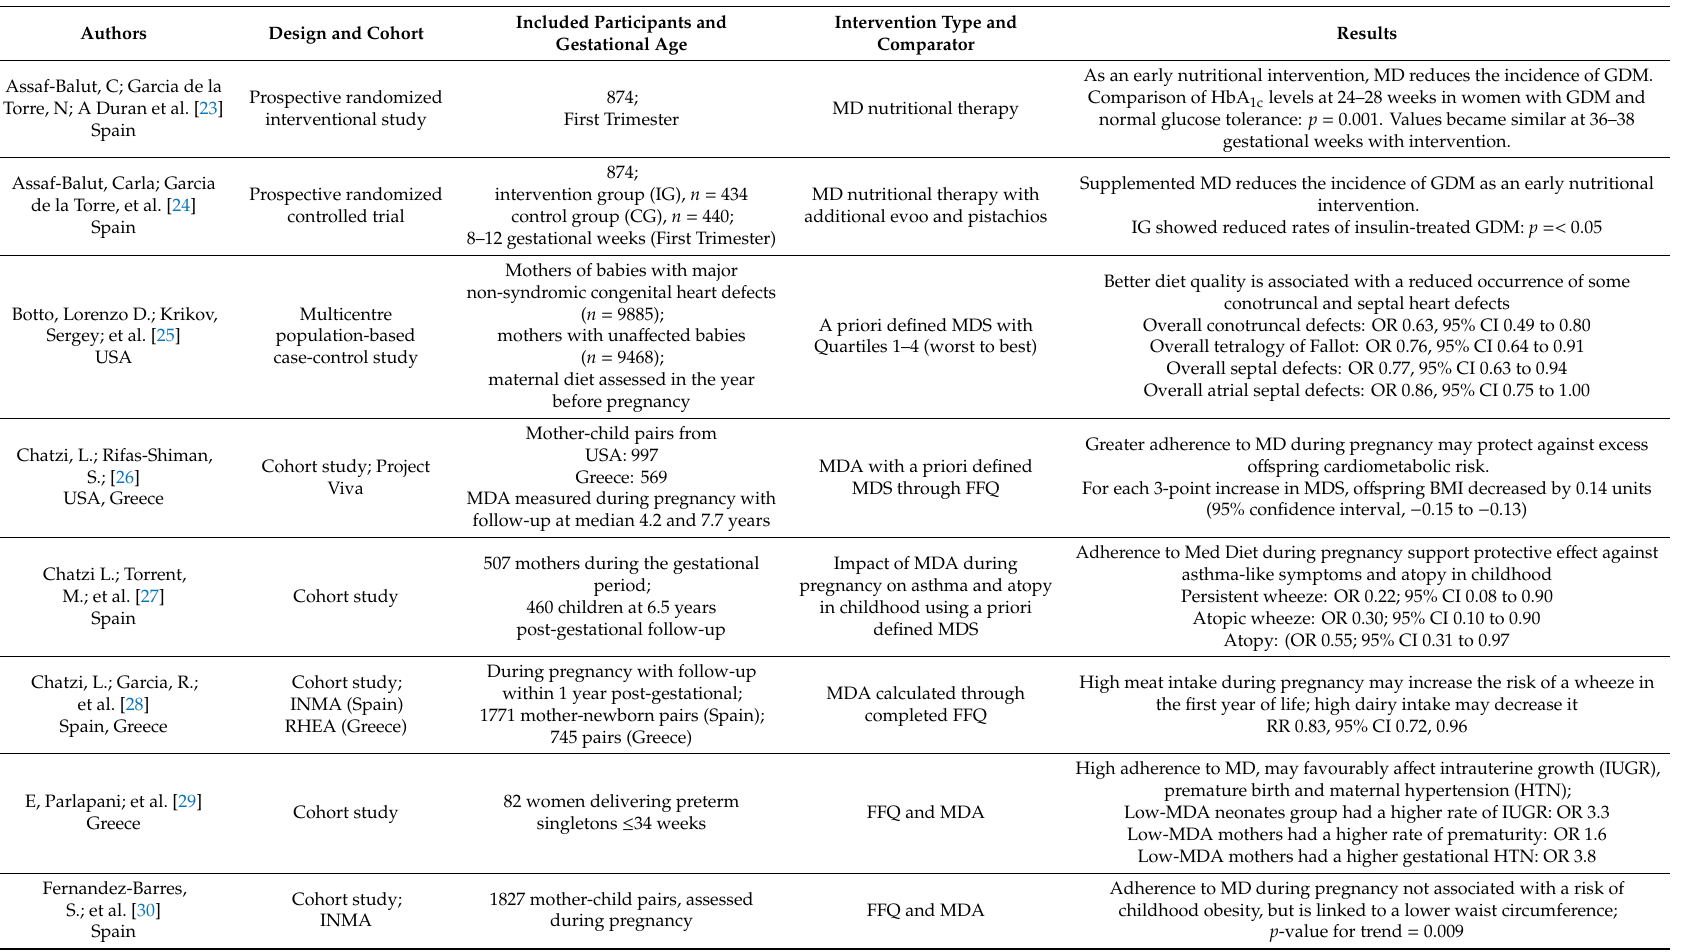
Table 2. The outcomes and e ff ect estimates for the included